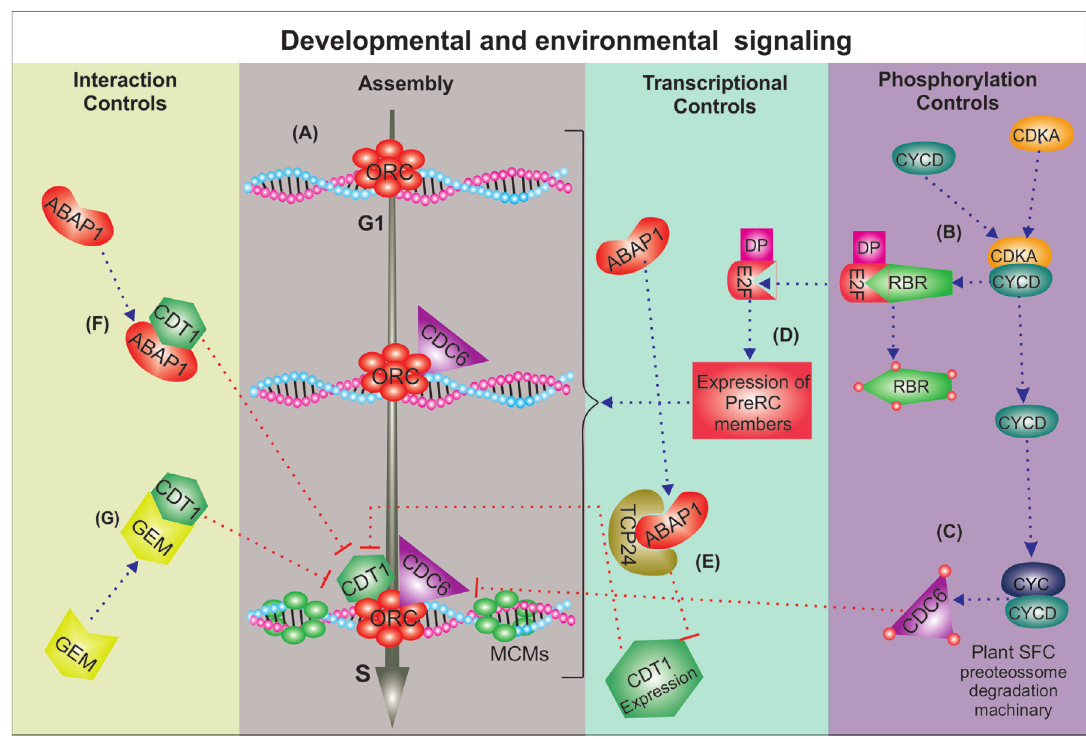
Figure 2 - Hypothetical model of pre-RC formation and regulation in plants. (A) Pre-replication complex (Pre-RC) assembly, activation and prevention of DNA re-replication is regulated by three major levels of controls that act in a coordinated way, connecting cell cycle progression with endogenous and exogenous (environmental) signaling. Protein phosphorylation by CDK/cyclin regulates different steps of DNA replication licensing: (B) first, they phosphorylate retinoblastoma protein, releasing E2F/DP to (D) activate transcription of pre-RC genes; (C) later, phosphorylation of members of the pre-RC promotes initiation of DNA replication and prevents DNA re-replication through nuclear exclusion and/or protein degradation. In addition to the transcriptional regulation by E2F/DP (D), pre-RC assembly is limited by repression of CDT1 transcription (E) by ABAP1/TCP24 (F), which also inter- acts directly with CDT1. (G) GEM also competes for binding to CDT1 making it less available for pre-RC